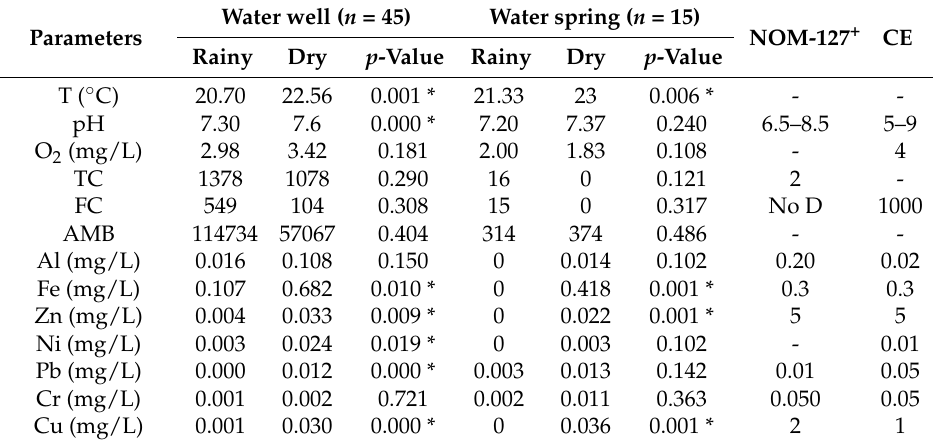
Table 4. TC densities in Wells, ranged around 1000 NMP/100 mL.